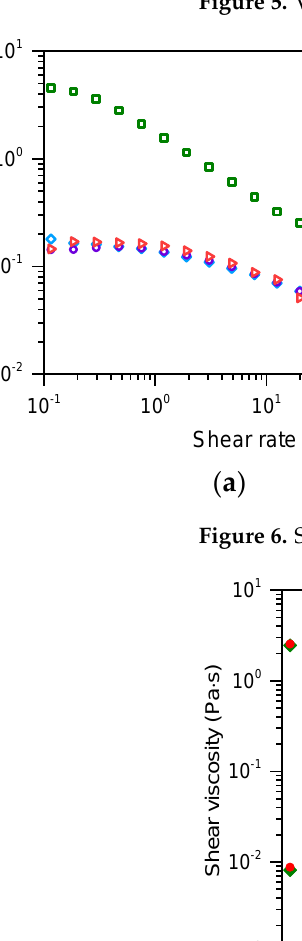
Figure 5. Viscous (G ″ ) and elastic (G ′ ) moduli of HPAM and biopolymer.